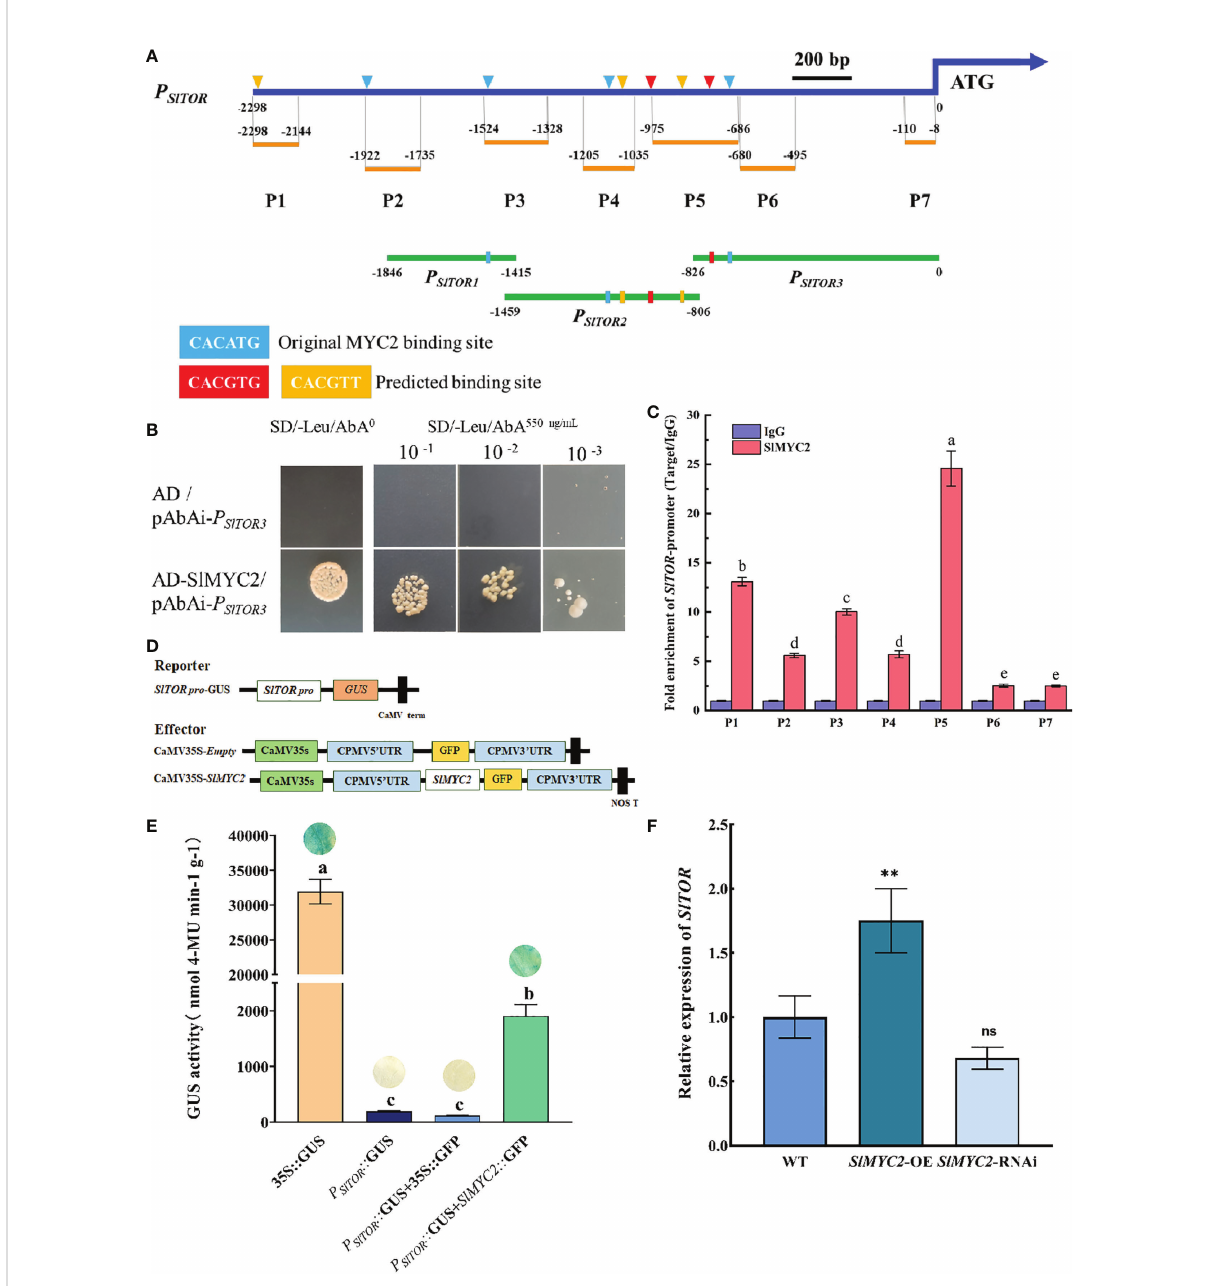
FIGURE 7 Interaction between SlMYC2 and the SlTOR promoter. (A) Schematic diagram of segments of SlTOR promoter in yeast one-hybrid and ChIP assays. P SlTOR1 , P SlTOR2 and P SlTOR3 are segments of the SlTOR promoter in yeast one-hybrid assays, P1-P7 are segments of the SlTOR promoter in ChIP assays. CACATG is the original MYC2 binding site, CACGTG and CACGTT are the predicted binding sites which are predicted by PlantCARE. (B) Yeast one-hybrid assay. Take 4 m L of bacterial solutions of different concentrations and spread it on a 550 ng· m L -1 AbA SD/-Leu plate to observe the yeast growth. (C) Schematic representation of the SlTOR promoter and chromatin immunoprecipitation (ChIP) – qPCR assays showing the binding of SlMYC2 -OE to the SlTOR promoter upstream of the ATG start codon. P1-P7 represent partitions of the SlTOR promoter. Each ChIP value is normalized to its respective input DNA value, and enrichment is shown as the percentage of input. Error bars represent the SEM from three biological replicates. (D, E) Analysis of the SlTOR promoter activation by SlMYC2 using transient GUS activity assays. A 2-kb SlTOR upstream DNA fragment driving GUS was used as the reporter. The effectors were indicated in (D) . Measurement of transient GUS activity assay is shown in (E) . (F) Expression of SlTOR after SlMYC2 overexpression and silencing. Errors are standard deviations for three biological replicates (n=3). Differences between means were analyzed for signi fi cance using Student ’ s t test, *P < 0.05, **P < 0.01. ns, no signi fi cant difference. Different letters indicate signi fi cant differences among treatments. Multiple comparisons of means were performed using Tukey's test at the 0.05 signi fi cance